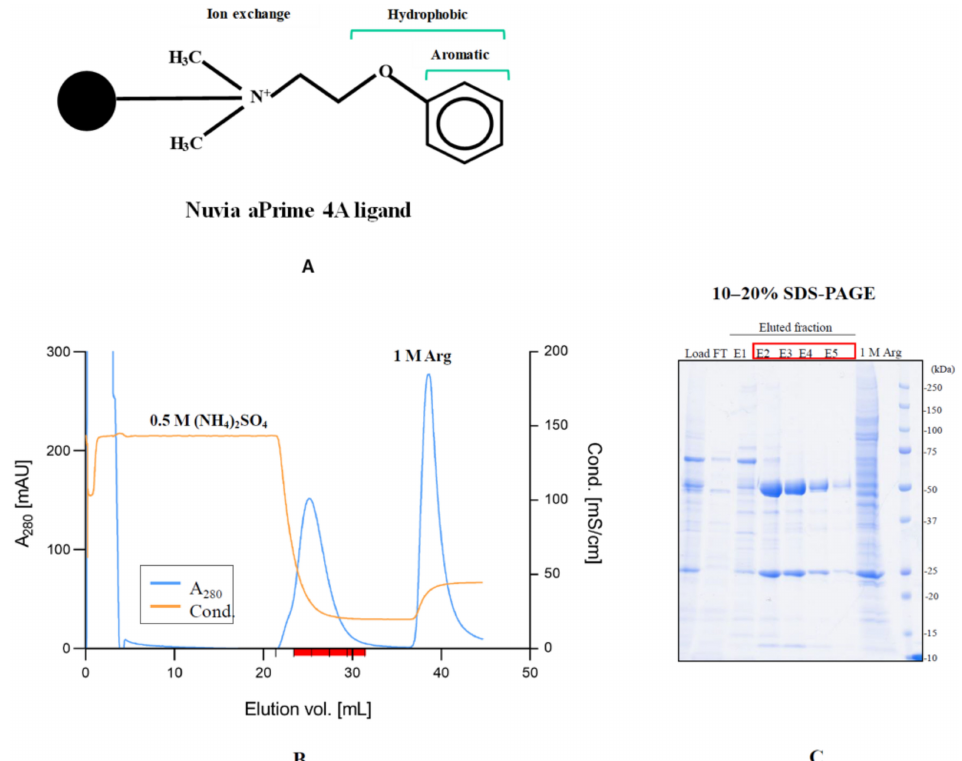
Figure 12. Purification of rabbit monoclonal antibody using Nuvia aPrime 4A mixed-mode chro- matography. ( A ). Structure of Nuvia aPrime 4A ligand ( B ). Elution chromatogram of rabbit antibody. Conditioned medium was adjusted to pH 7.6 with Tris-buffered saline (TBS) and made 0.5 M